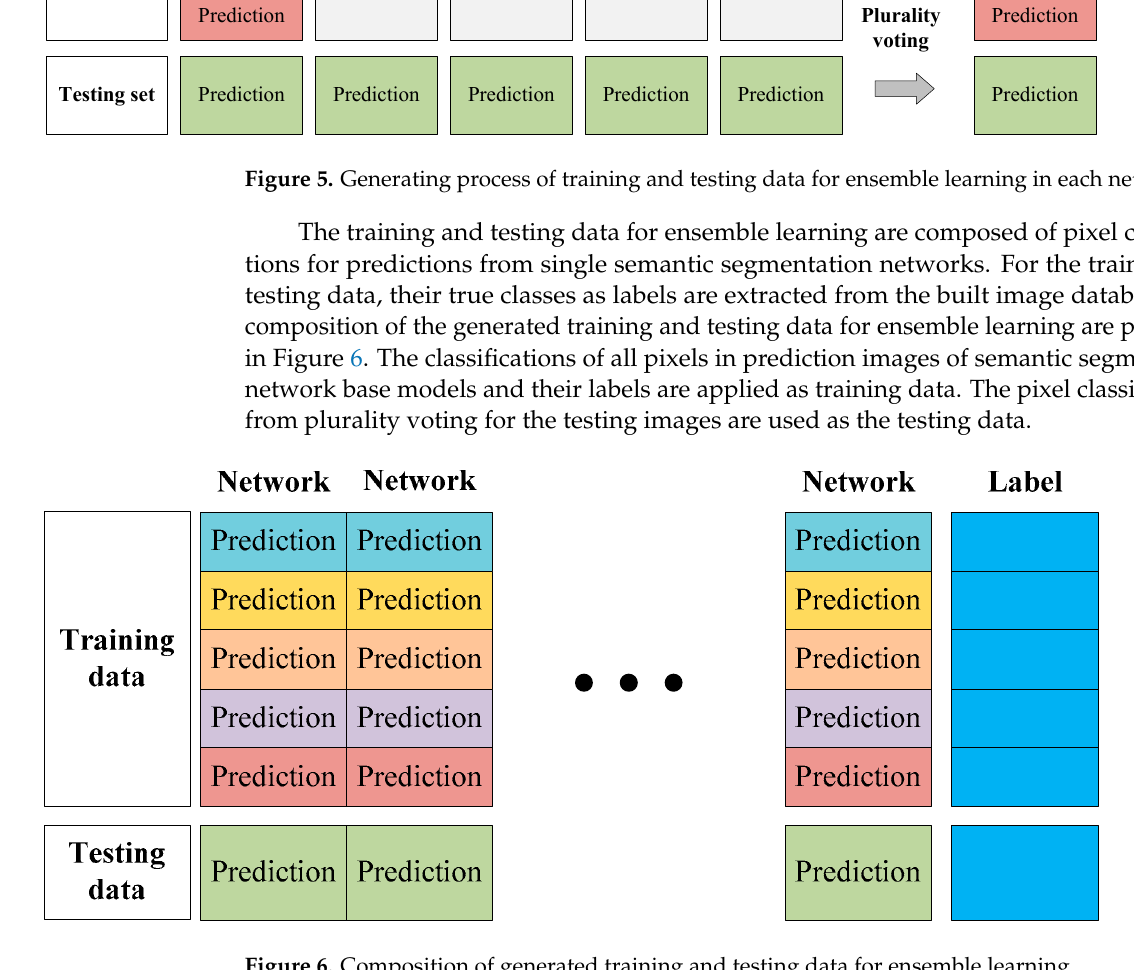
Figure 5. Generating process of training and testing data for ensemble learning in each network.